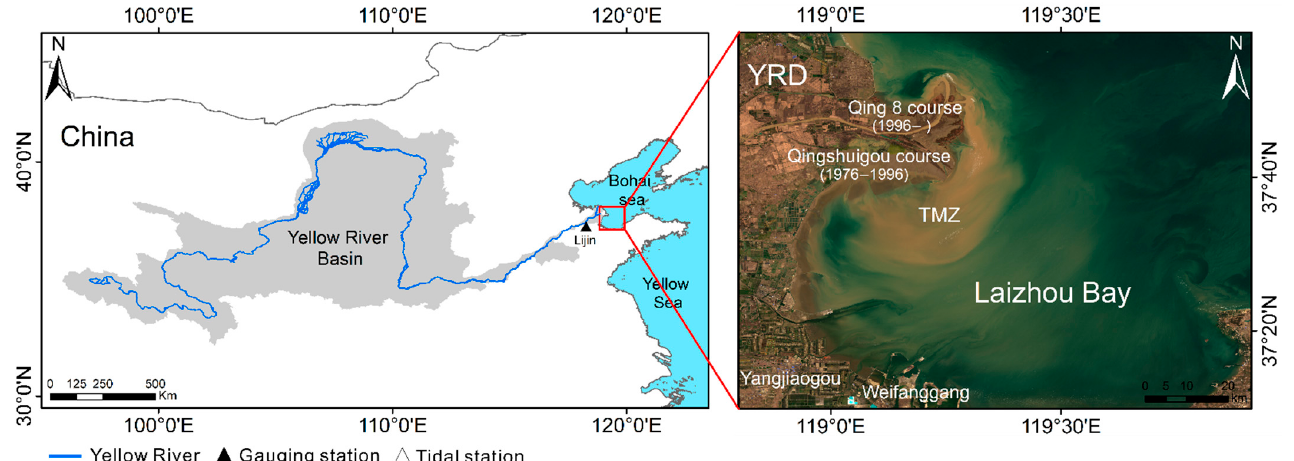
Figure 1. Location of the study area, displaying the extent of the Yellow River Basin ( left ) and the Yellow River estuary ( right ). TMZ: turbidity maximum zone; YRD: Yellow River